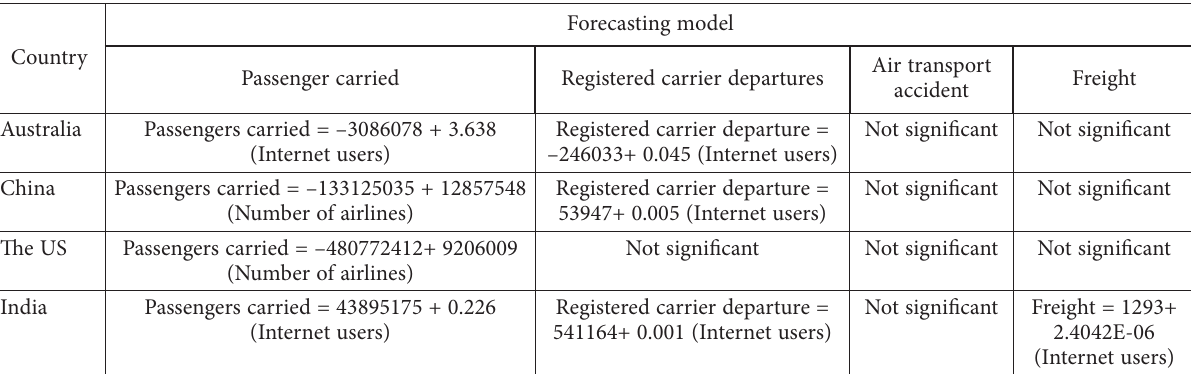
Table 7. Forecasting models for each countries’ ATS